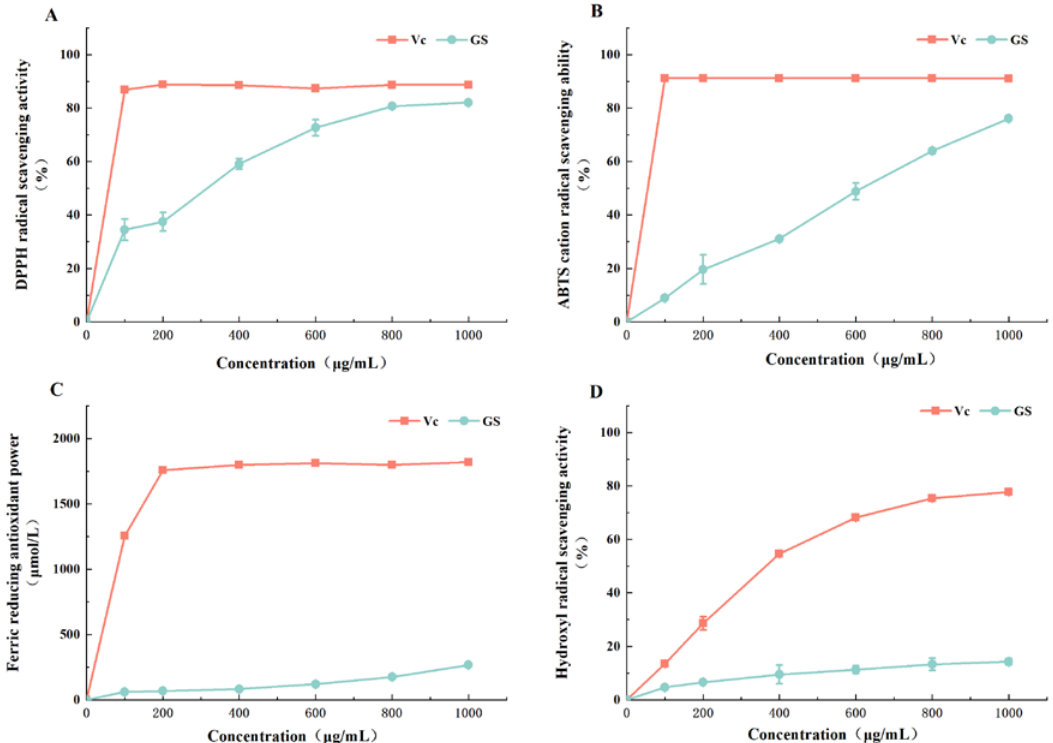
Figure 3. In vitro antioxidant activity of VWS. ( A ) DPPH radical scavenging activity; ( B ) ABTS radical cation scavenging activity; ( C ) Ferric reducing antioxidant power; ( D ) Hydroxyl radical scavenging activity.